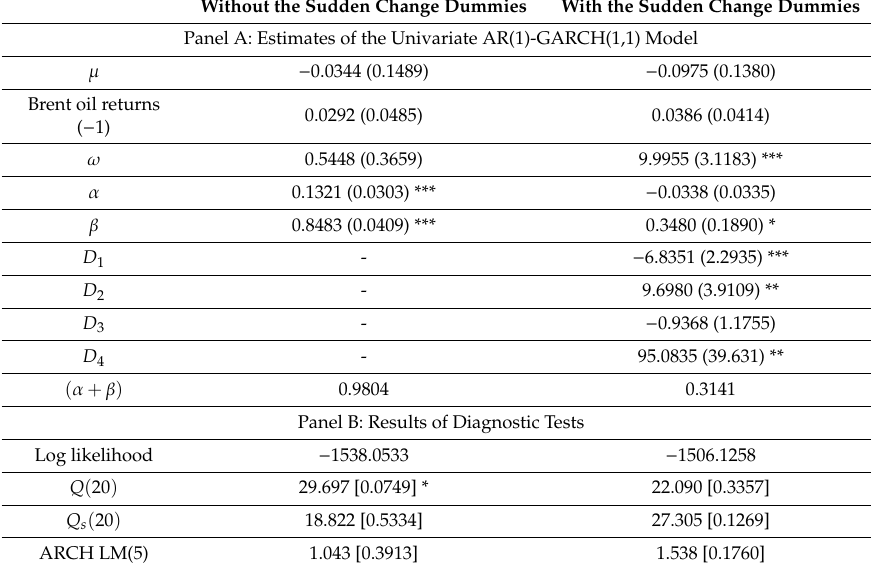
Table 5. Estimation results of AR(1)-GARCH(1,1) model for the Brent oil returns. Without the Sudden Change